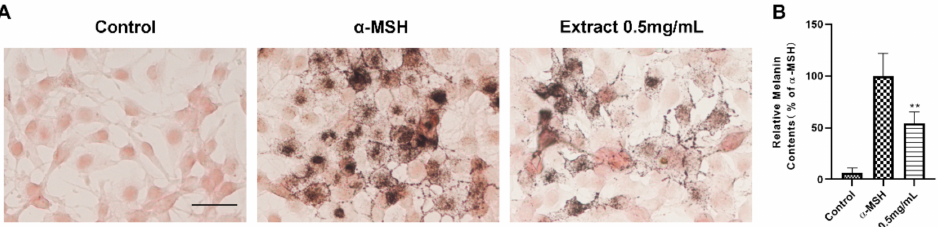
Figure 2. Extract of Vernonia anthelmintica (L.) Willd. induces melanogenesis. ( A ) Masson-Fontana melanin ammonia silver stain assay to test extract of Vernonia anthelmintica (L.) Willd. and α -MSH (20 nM) melanogenesis effect on B16F10 cells contrast to Control. Cells were treated for 48 h. The scale bars represent 50 µ m. ( B ) Collecting B16 cells in each group for testing melanin content (relative melanin contents % of α -MSH), results shown are mean ± SEM. Data were analyzed by ANOVA followed by post hoc Tukey test, ** p < 0.01 vs. α